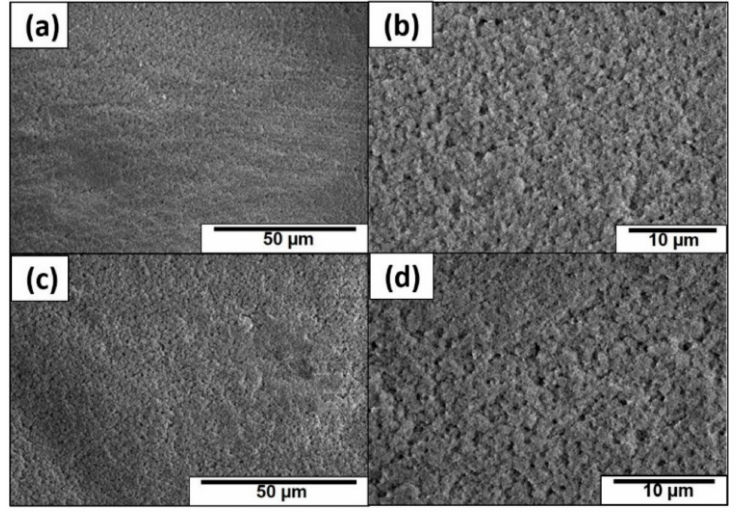
Figure 2. Scanning electron microscope (SEM) images of the superhydrophobic aluminum surfaces with the Coating A ( a , b ) and Coating B ( c , d ).